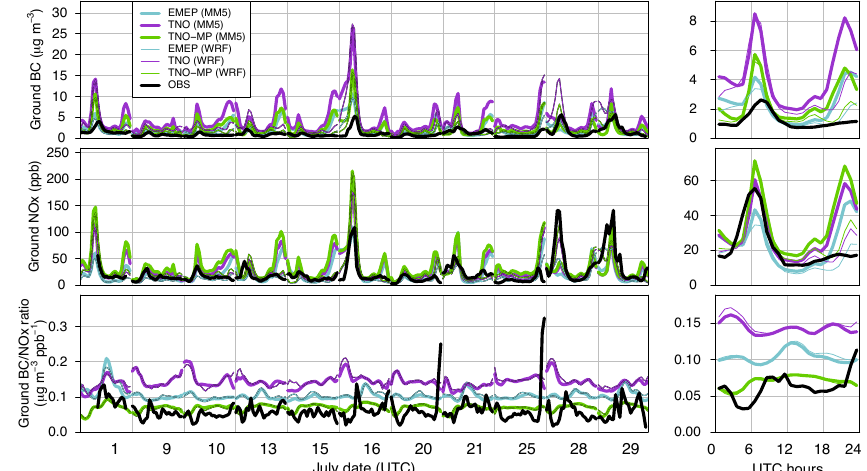
Figure 3. BC and NO x concentrations and BC / NO x ratio at the LHVP urban background site during July flight dates (left panels) and associated diurnal profiles (right panels).